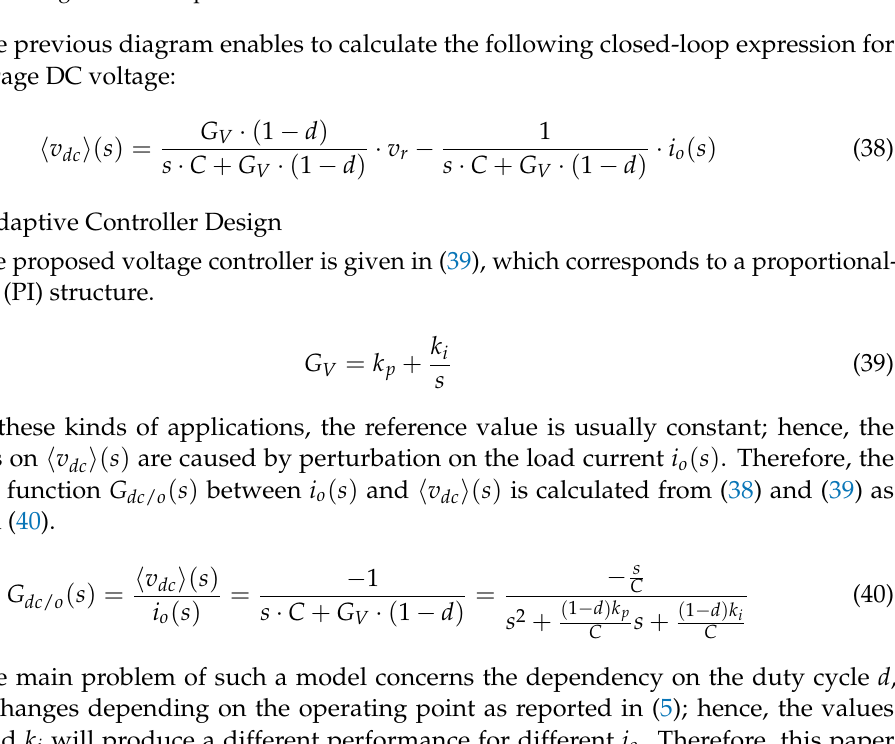
Figure 5. Voltage control